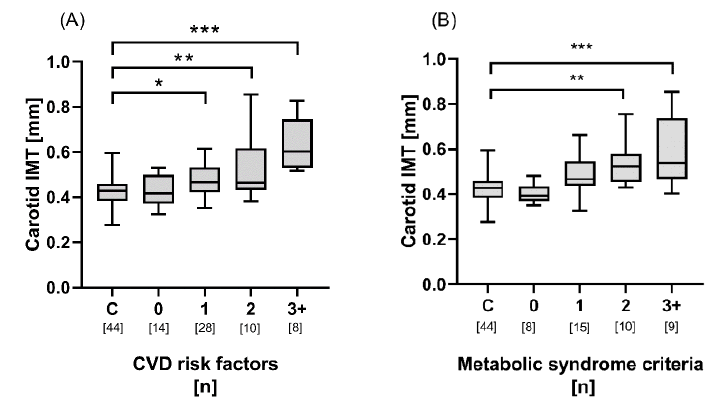
Figure 3. Comparison of carotid artery intima-media thickness (IMT) among controls (C, n = 44) and HSCT ( n = 60) with ( A ) 0, 1, 2, and 3+ of the following cumulative number of cardiovascular disease (CVD) risk factors: hypertension (systolic blood pressure >130 mmHg, diastolic blood pressure >85 mmHg, or antihypertensive medication), HbA1c > 42 mmol/mol, BMI > 30 g/m 2 , anthracycline cumulative exposure > 150 mg/m 2 , and hsCRP >2.5 mg/L and ( B ) 0, 1, 2, and 3+ of the following cumulative number of American Heart Association guideline metabolic syndrome criteria (out of